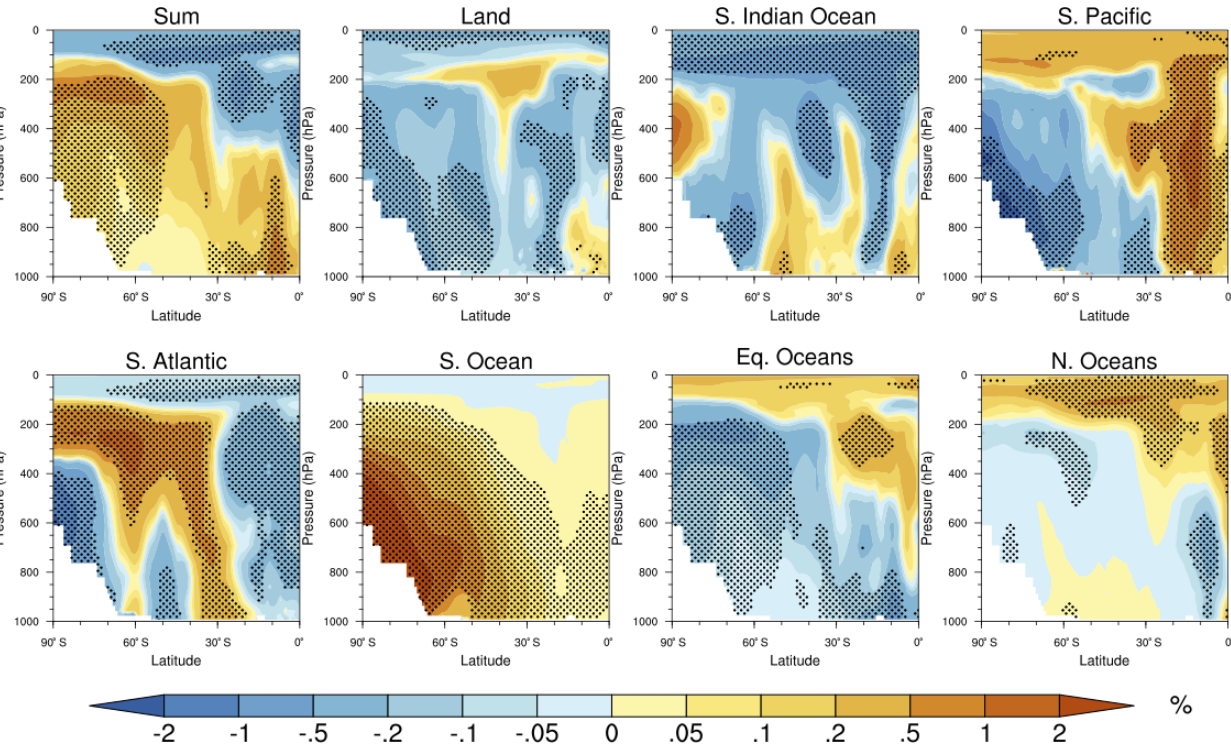
Figure 9. Vertical distribution of differences in fractional contribution to annual and zonal mean water vapor mixing ratio between the low- and high-SIC cases. Note that the contour intervals are non-uniform. Stippling indicates that the differences are statistically significant at the 90% confidence level based on Student’s t